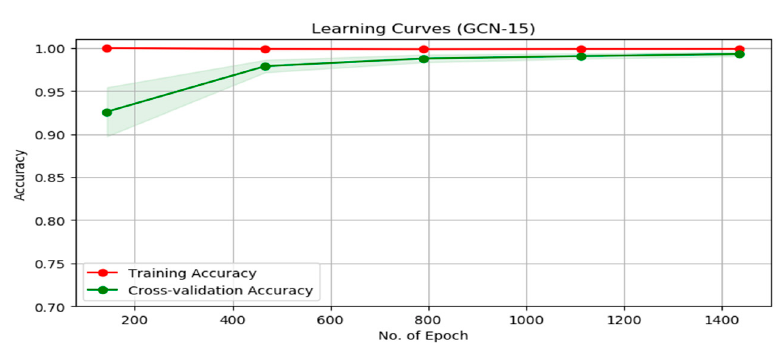
Table 3. The parameter values of the fitted GCN-MI network with 15 layers. Parameter Value Parameter Value Learning Rate 0.02 Epochs 600 Hidden layers 15 Dropout 0.2 Weight Decay 10,000 Early Stopping 10 The function of the middle layers of this network was ReLU and the subordinate of the last layer was Softmax. The learning curve shows that the training accuracy is at a high level and the model fits are good. It also shows that after 600 epochs, the cross-validation accuracy converged to the training accuracy (Figure 6).